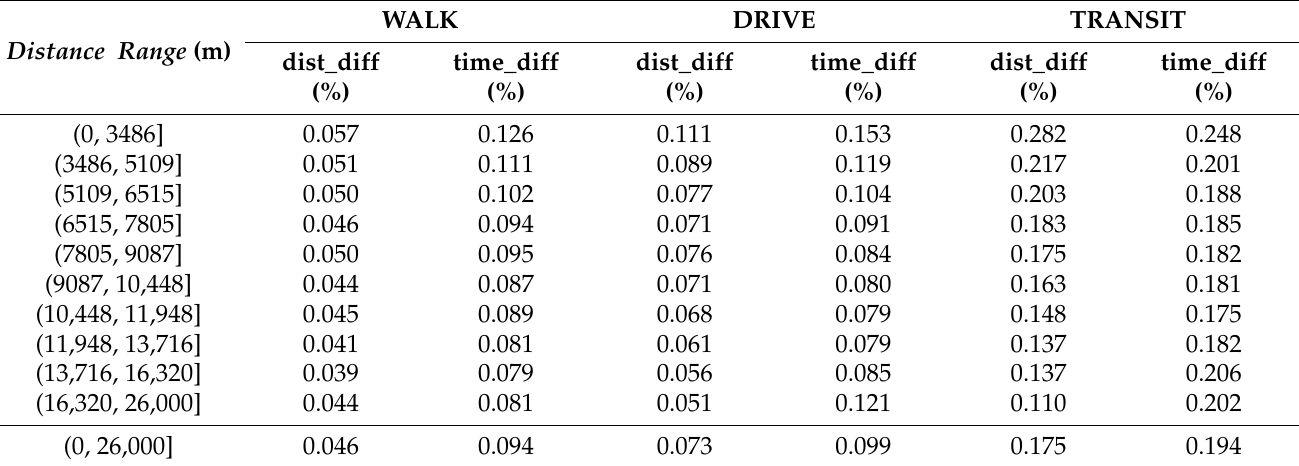
Table 5. Comparison, by time and distance, between the routes created using the Multimodal Urban Network and Google Maps. Values represent the average of the absolute ratio